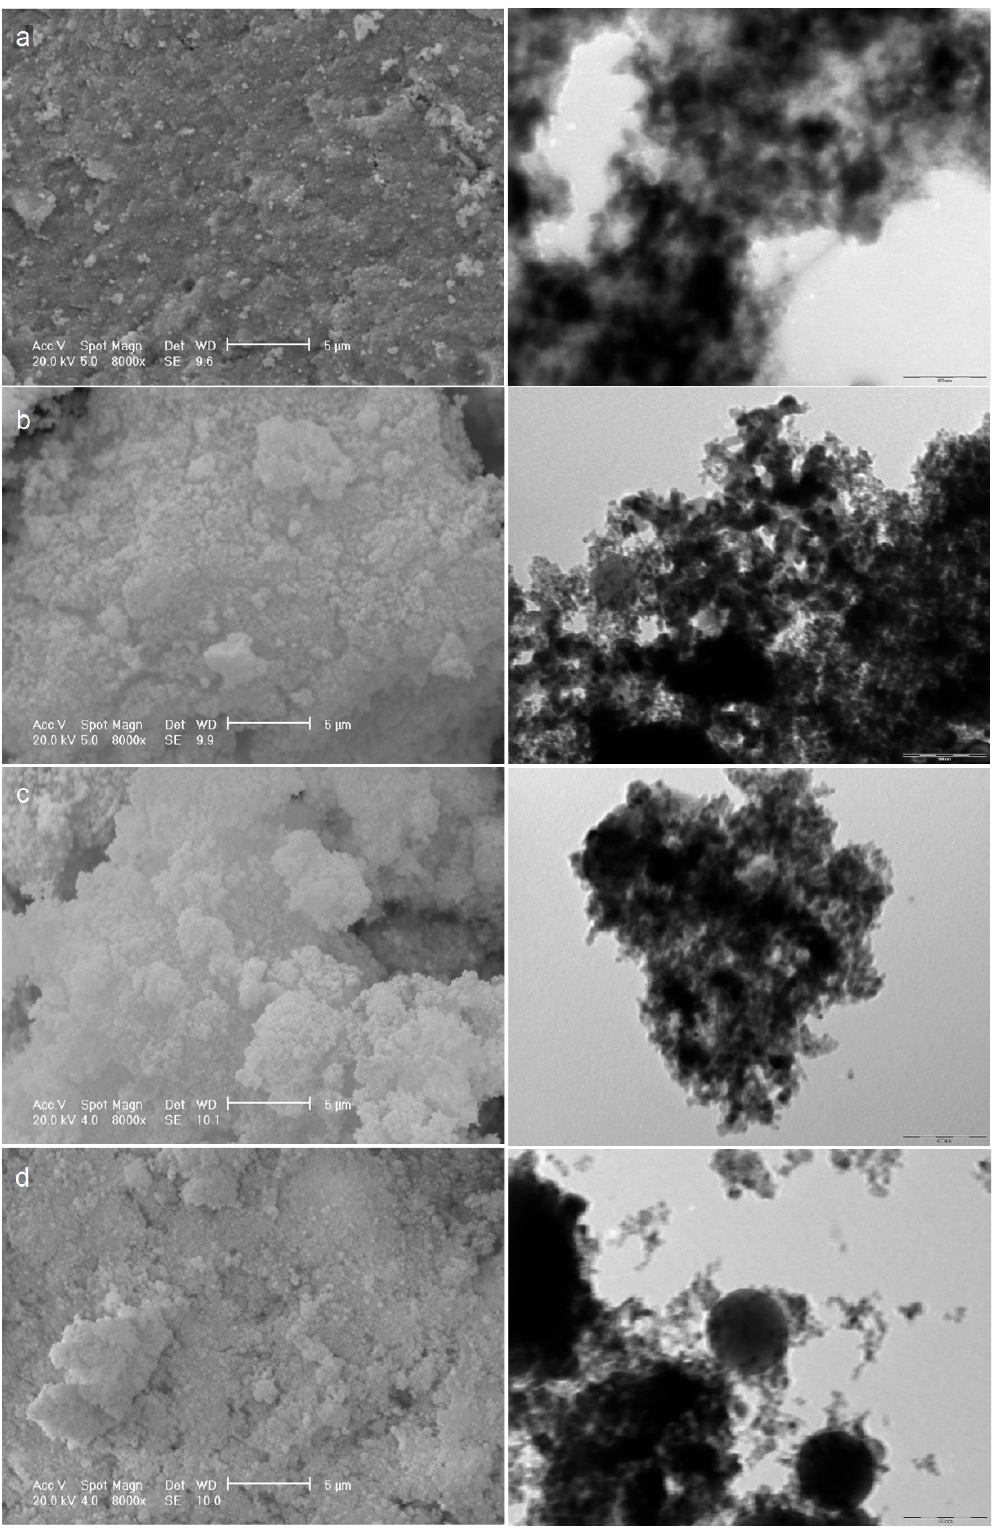
Figure 2. SEM (left, marker size 5 µm) and TEM (right, marker size 100 nm) micrographs of selected samples ( a ) La 0.3 Zr 0.7 NiO 3 ; ( b ) La 0.3 Ce 0.7 O 3 ; ( c ) La 0.8 Sr 0.2 NiO 3 ; ( d ) 10 wt% Ni/(0.3La 2 O 3 -0.7ZrO 2 ).